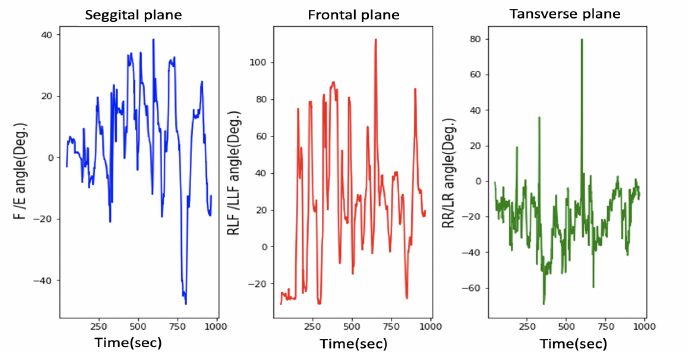
Figure 15. Head movement in 3 dimensions for a child with